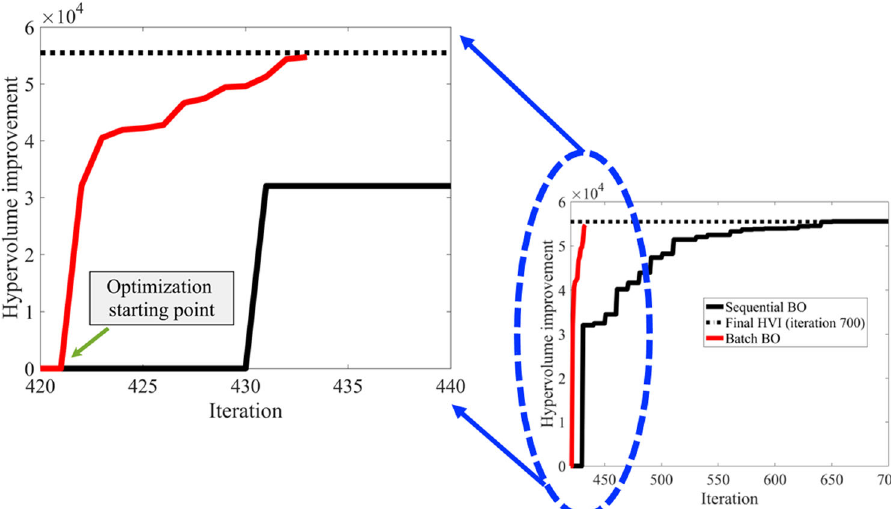
Fig. 3 Comparison of hyper-volume improvements in batch and sequential Bayesian optimization. Only 13 iteration is needed to reach the same Pareto front estimation quality in comparison to the sequential approach. 48 cores are accessible in our supercomputing system. Thus, it is possible to run 48 experiments in parallel without additional wall-time in batch Bayesian optimization case.